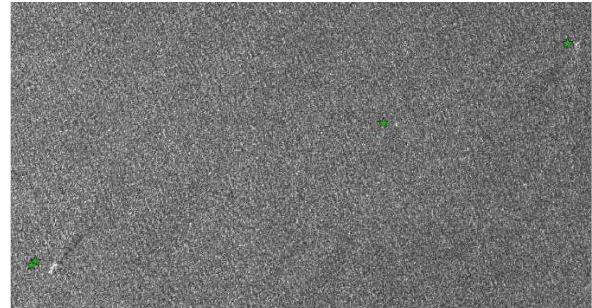
Figure 4. Ship detection results on a NovaSAR-1 20-m ScanSAR image